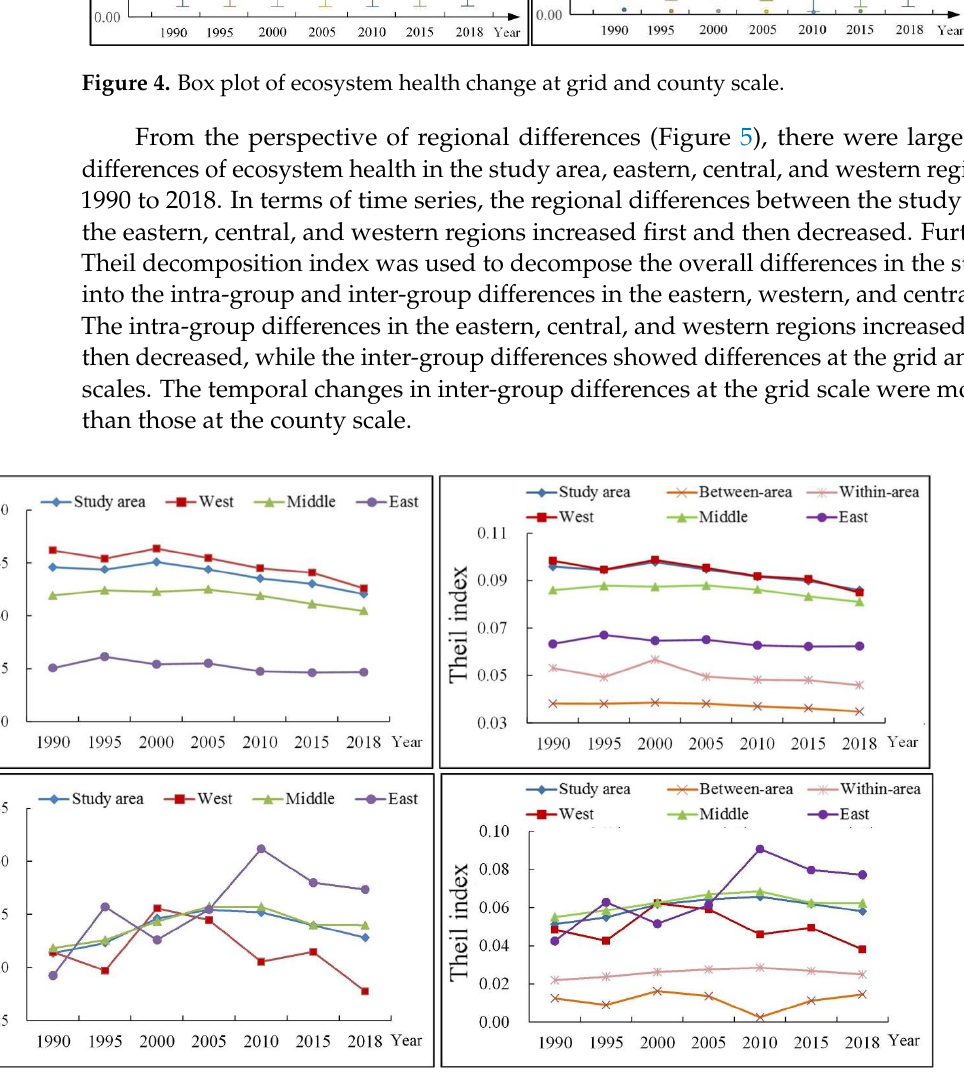
Figure 5. Variation trends of the variance coefficient and Theil index of ecosystem health at grid and county scale.